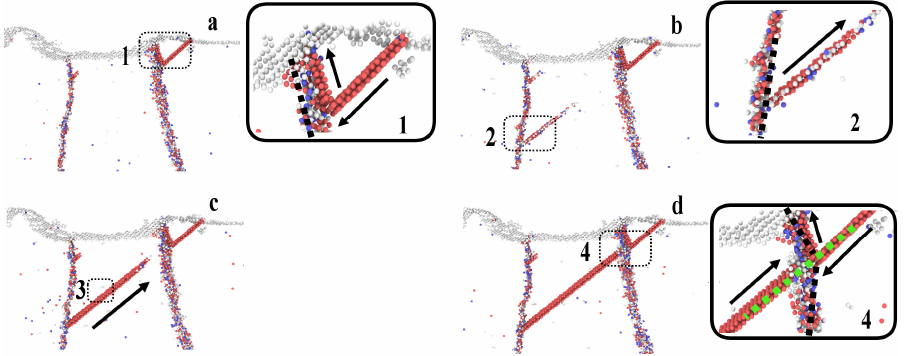
Figure 9. The effect of grain boundaries on the nucleation of defect dislocations, ( a – d ) are the process of grain boundaries hindering the development of defects.